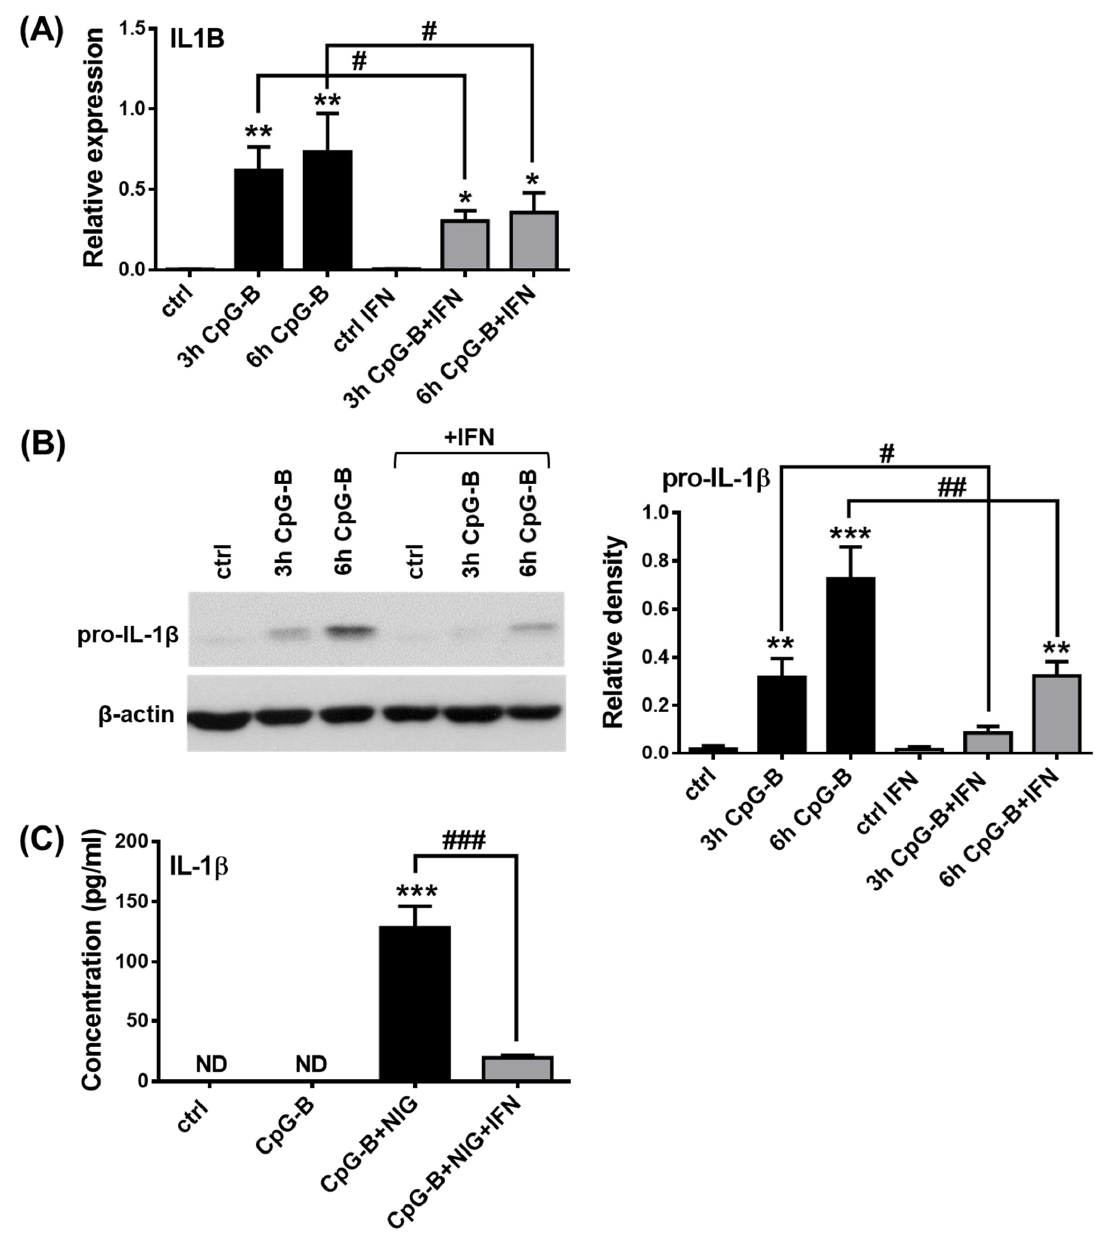
Figure 6. IFN- α pretreatment inhibits the IL-1 β production in the human GEN2.2 pDC cell line. Cells were pretreated with 50 µ g/mL recombinant IFN- α for 30 min, then activated with 1 µ M CpG-B for 3 or 6 h ( A , C ). To induce IL-1 β secretion CpG-B-treated cells were incubated in the presence of 20 µ M nigericin for 4 h ( C ). The expression of IL1B was determined at the mRNA level by qPCR ( A ) and at the protein level by Western blotting ( B ) and ELISA ( C ). A representative blot is shown in ( B ). Bar graphs represent the mean ± SD of 6 independent experiments. Data were analyzed using one-way ANOVA followed by Bonferroni’s post-hoc test. * p < 0.05, ** p < 0.01, *** p < 0.001 vs. control (ctrl), # p < 0.05, ## p < 0.01, ### p < 0.001. IFN: interferon, ND: not determined, NIG: nigericin.